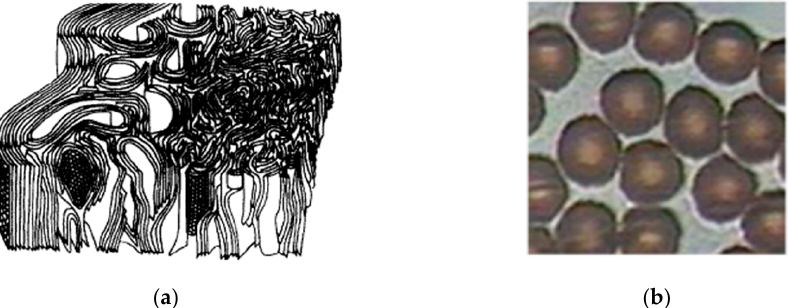
Figure 1. Skin-core structure of PAN fiber of ( a ) skin-core structural model of carbon fiber [10] and ( b ) micrograph of skin-core structure of pre-oxidized fiber [12].